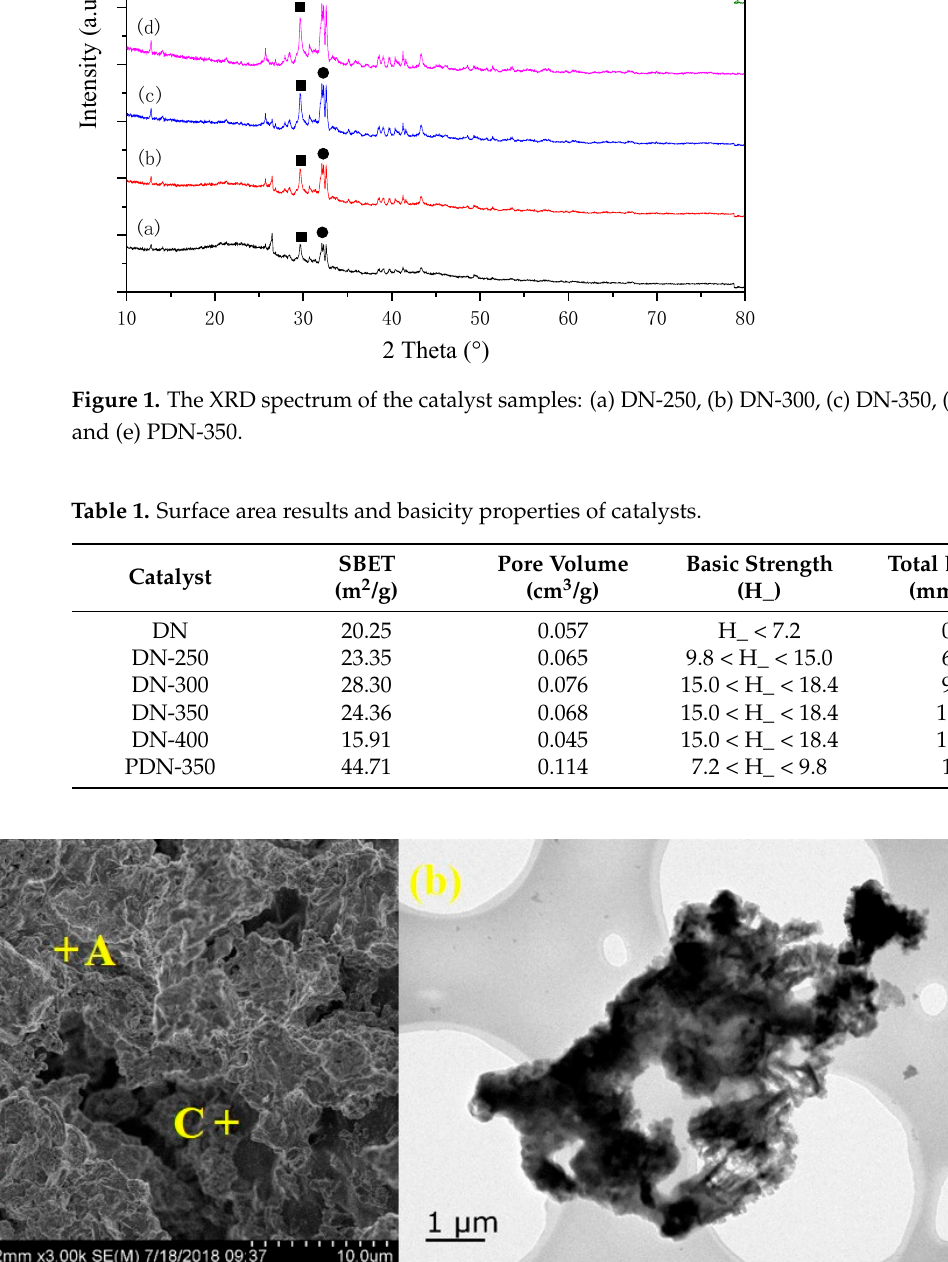
Figure 2. The SEM image ( a ) and TEM image ( b ) of the catalyst. A, B and C were the typical points to determine the elemental contents.